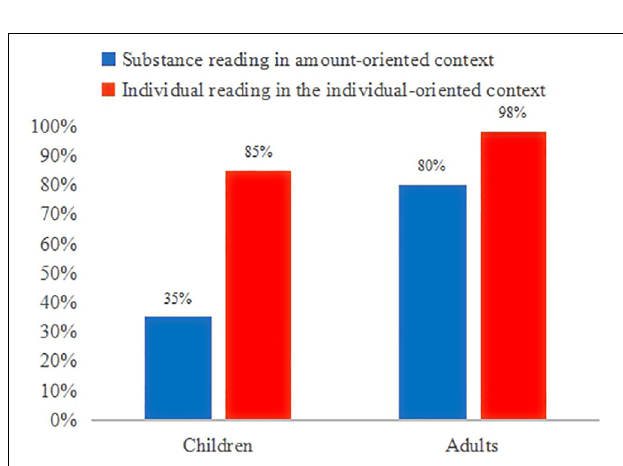
FIGURE 5 | Children’s and adults’ interpretation of duo-shao sentences in the two distinct